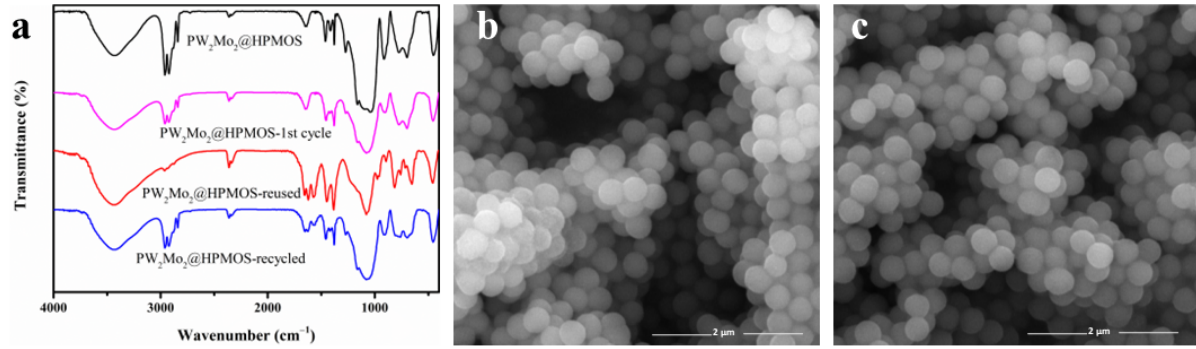
Figure 9. FT-IR spectra of reused and recycled samples ( a ), SEM images of a reused sample ( b ), and a recycled sample ( c ).